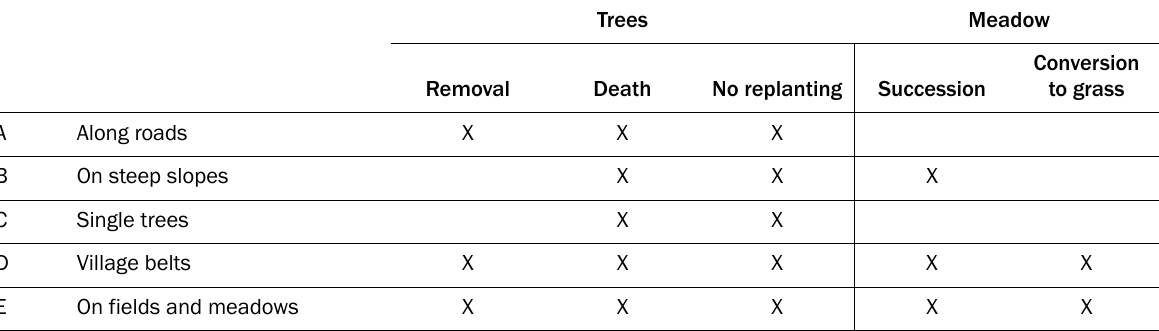
Table 2. Orchard Meadow Types and the Primary Mechanisms of Decline